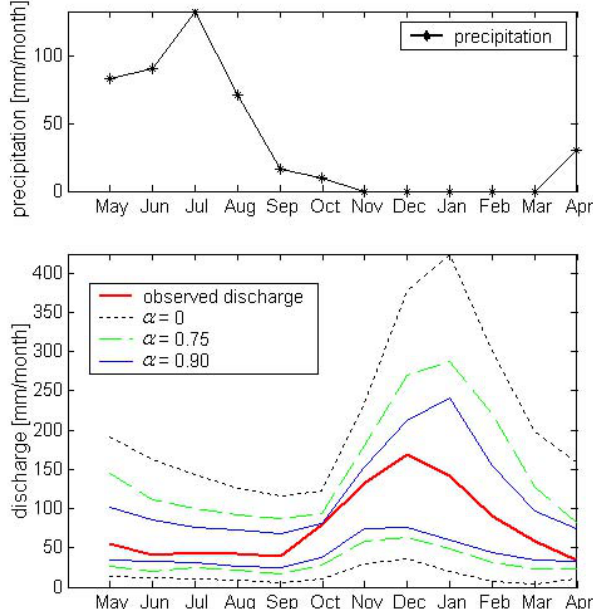
Fig. 7. Precipitation history, observed discharge and selected pos- sibility bounds derived from the aggregate possibility distribution π agg 1 for the hydrological year